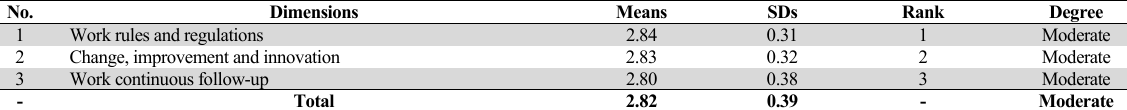
Means and standard deviations of employee performance degree in light of visual management No. Dimensions Means